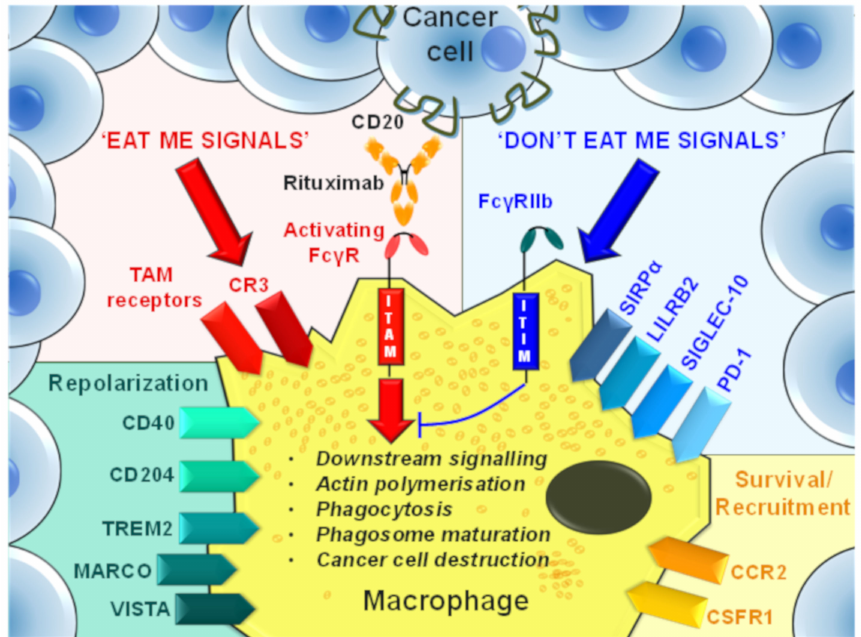
Figure 3. TAM cell surface molecule candidates for mAb targeting. TAM cell surface